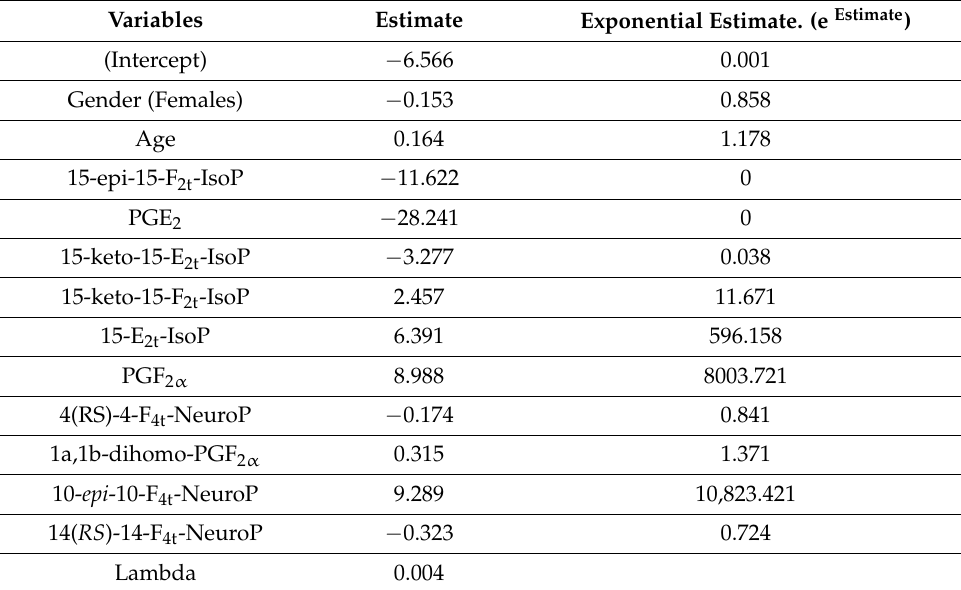
Figure 2. Correlation plots between plasma metabolites and CSF biomarkers. Table 4. Model